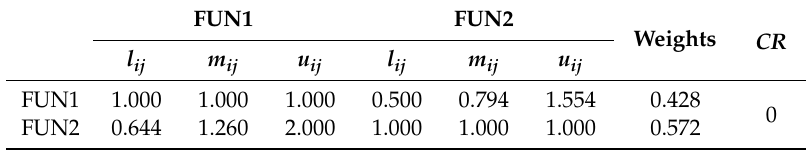
Table 7. Combined judgement matrix using geometric means for the subcriteria of the criterion